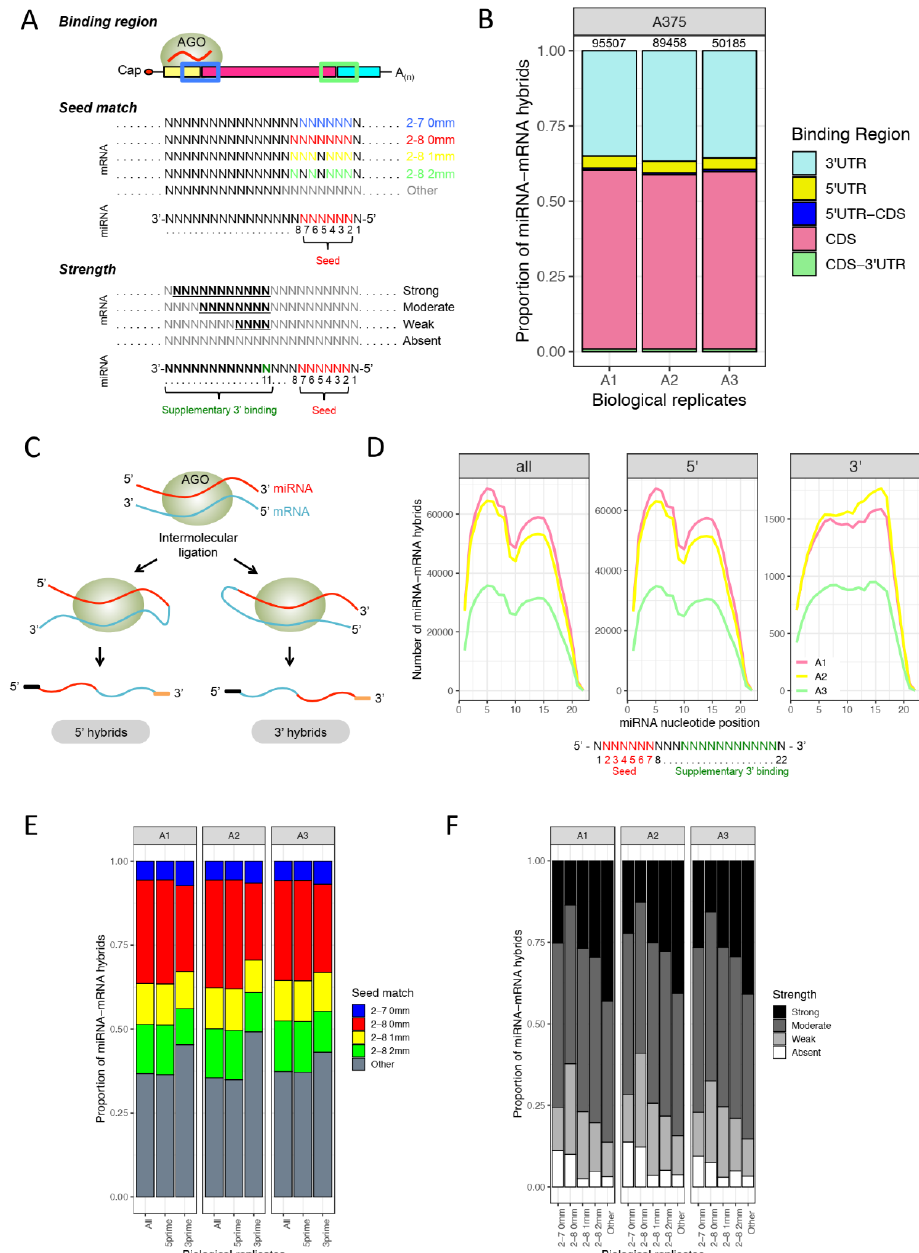
Figure 2. Characteristics of miRNA-mRNA hybrids discovered in melanoma cells. ( A ) Binding characteristics of miRNA–mRNA interactions. Binding region: mRNA part of the hybrids mapped to the ENSEMBL transcript database with regions corresponding to the 5 ′ UTR and 3 ′ UTR, CDS, 5 ′ -UTR-CDS, and CDS-3 ′ UTR. Seed match: nucleotides (nt) 2–7 at 5 ′ end of miRNA with zero (2–7, 0 mm), 2–8 with zero (2–8, 0 mm), one (2–8, 1 mm), or two mismatches (2–8, 2 mm), and the remaining binding modes were classified as “other”. Seed pairing at nucleotides 2–7 (blue) and 2–8 (red) without mismatches was considered as canonical seed pairing, whereas any additional type of pairing was referred to as non-canonical seed pairing. Strength: “strength” of binding outside the seed region at the 3 ′ end of the miRNA based on number of bound nt: >8 nt (strong), 5–8 nt (moderate), 1–4 nt (weak), and 0 nt (absent). ( B ) Proportion of miRNA-mRNA hybrids across three biological replicates of the BRAF-mutant melanoma cell line A375 (A1, A2, and A3) with miRNA binding sites mapped to the mRNA sequence, and the number of identified hybrid sequences in each replicate. Hybrid mRNAs for which the transcript was not annotated in the corresponding database were excluded. The number above the bars displays the number of hybrids identified in each biological replicate. ( C ) The two types of miRNA-mRNA hybrid molecules that were generated during the intermolecular ligation: 5 ′ and 3 ′ miRNA hybrids, in which the miRNA is located at the 5 ′ end or the 3 ′ end of the hybrids, respectively. ( D ) M-plots showing the number of miRNA-mRNA hybrids bound at each miRNA nt position ( x -axis, nt 1–22), and showing that most genes are targeted via the seed sequence but also with supplementary sites in the 3 ′ region of the miRNA. ( E ) The type of seed pairing (5 ′ miRNA sequence) was divided into classes as shown in ( A ). The proportion of